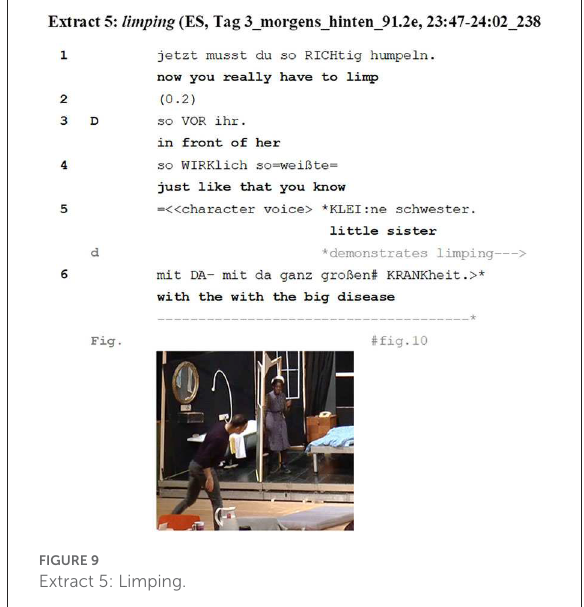
FIGURE9 Extract 5: